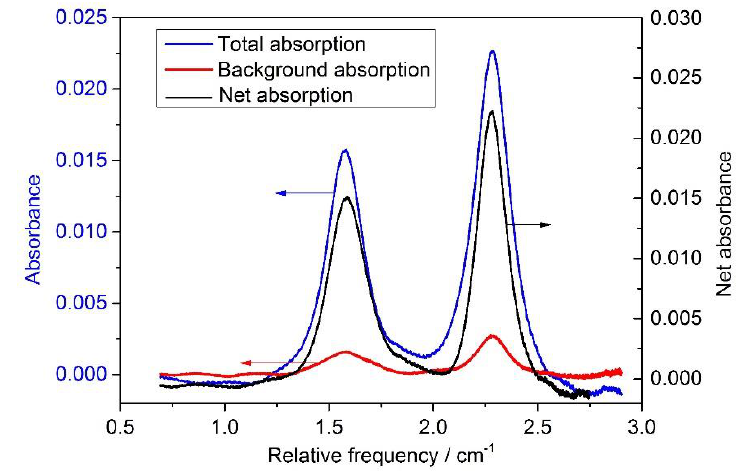
Figure 5. Total absorption (blue line) and background absorption (red line) at a temperature and a pressure. The net absorption (black line) was obtained as their difference.